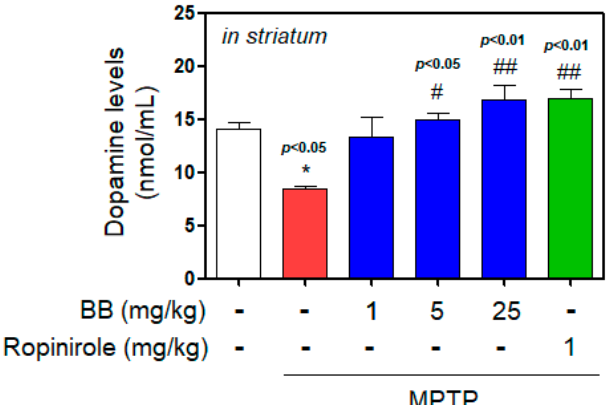
Figure 2. Effects of BB on MPTP-induced dopamine contents. Dopamine contents in the striatum (ST) of mice brain was measured using enzyme-linked immunosorbent assay (ELISA). Values represent means ± S.E.M. * p < 0.05 compared with the control group, and # p < 0.05 and ## p < 0.01 compared with the MPTP-treated group or control group.